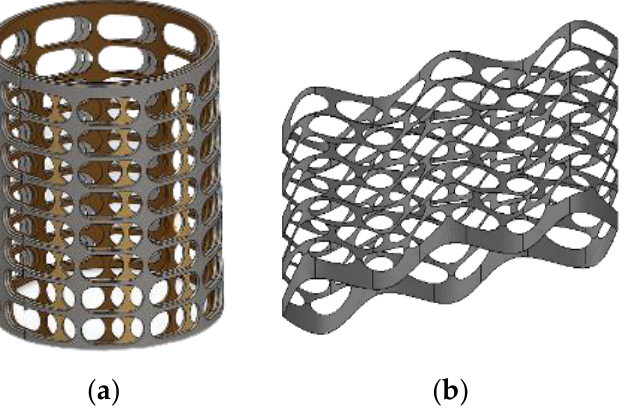
Figure 15. Products with a permeable structure: cylindrical shape(s), obtained by folding a tape or sheet and welding to the height of the cylinder(s) ( a ); with complex spatial configuration, obtained by profiling tapes and connecting them by spot welding ( b ).